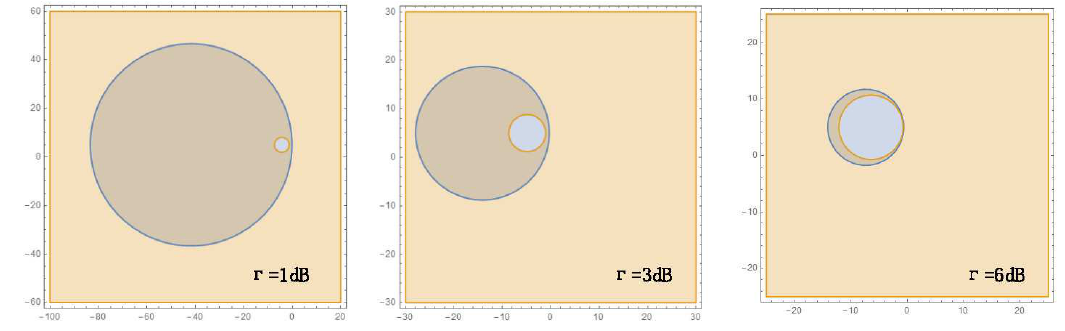
Figure 5. The capture margin of the τ with fixed z .